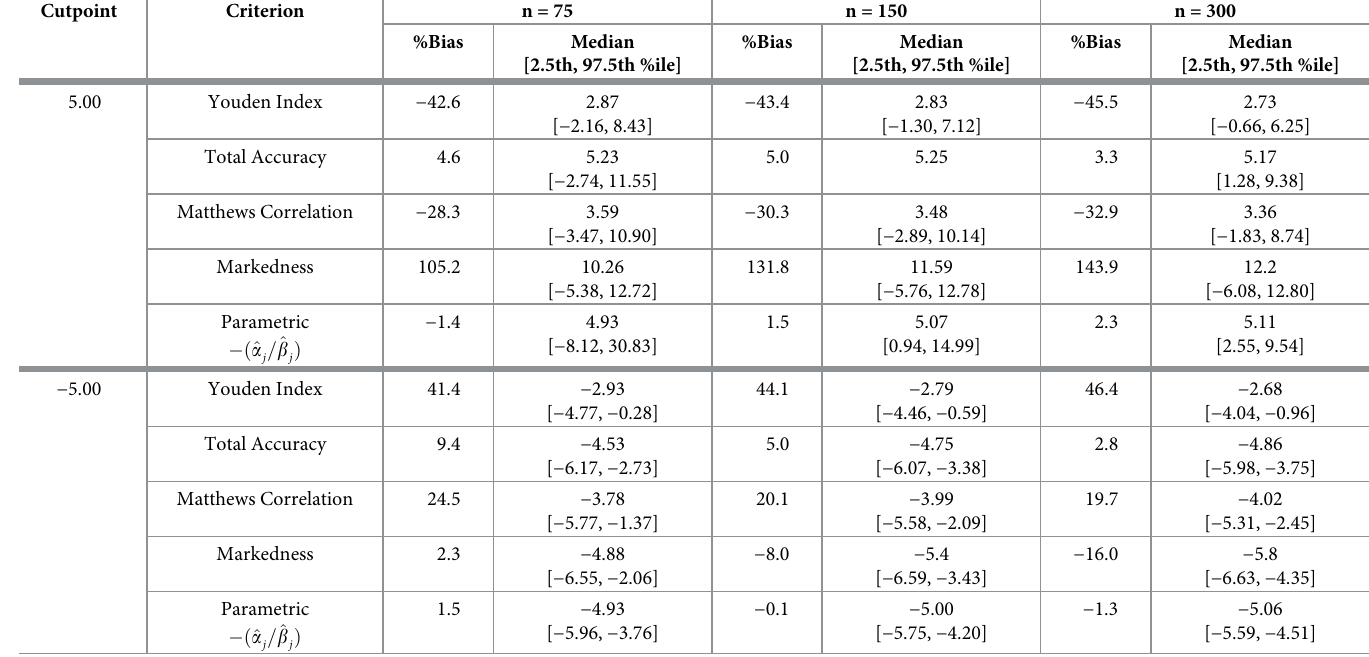
Table 7. Non-proportional odds simulation: NPO2. Percentiles and biases of cutpoints selected from cumulative ROC curves with several criteria and computed para- metrically: 10,000 simulated datasets parameterized for non-proportional odds, AUC 1 = 0.70, and AUC 2 = 0.95.